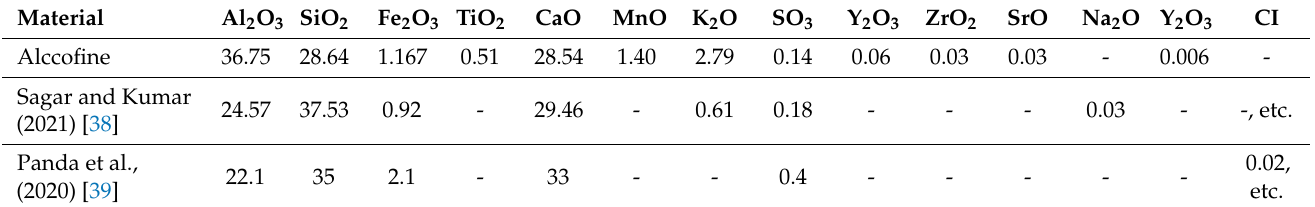
Table 5. Chemical composition of alccofine.